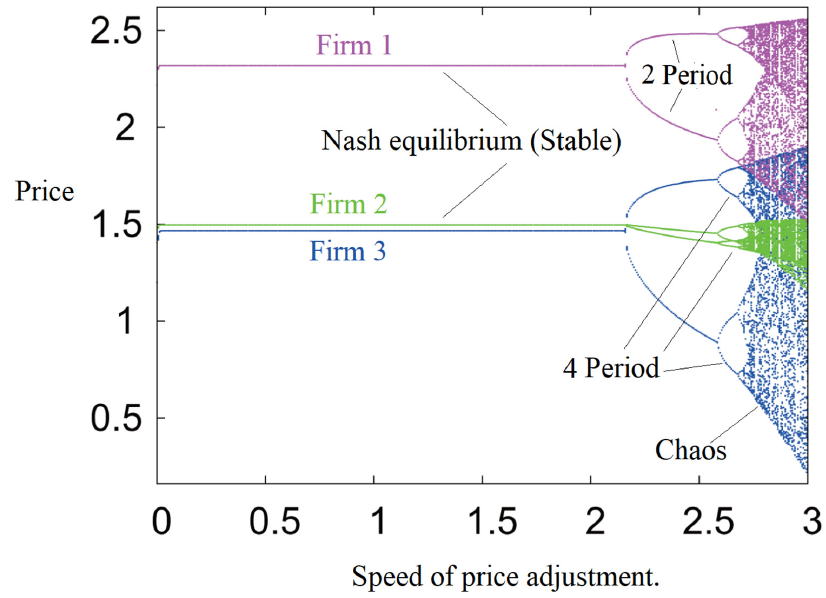
Figure 11. The Flip bifurcation [11].